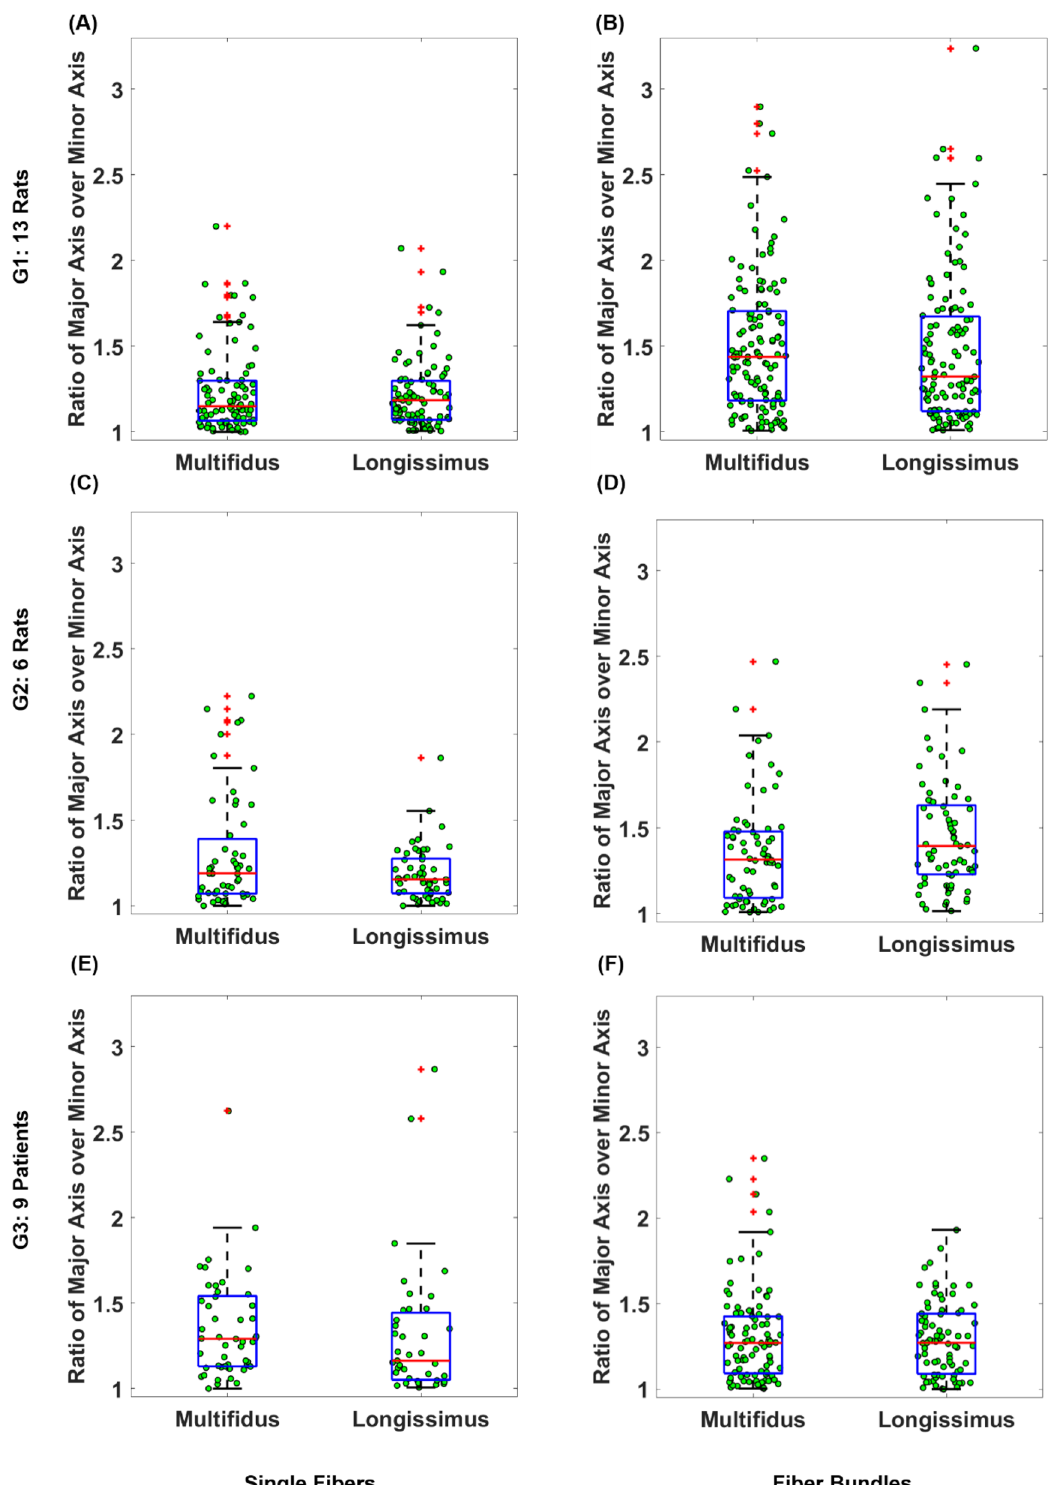
Figure 4. Boxplot representation of ratio of major over minor axes of single fibers and fiber bundles tested in G1 ( A , B ), G2 ( C , D ), and G3 ( E , F ). The red lines represent the medians, the heights of the boxes represent the interquartile ranges and red crosses identify the